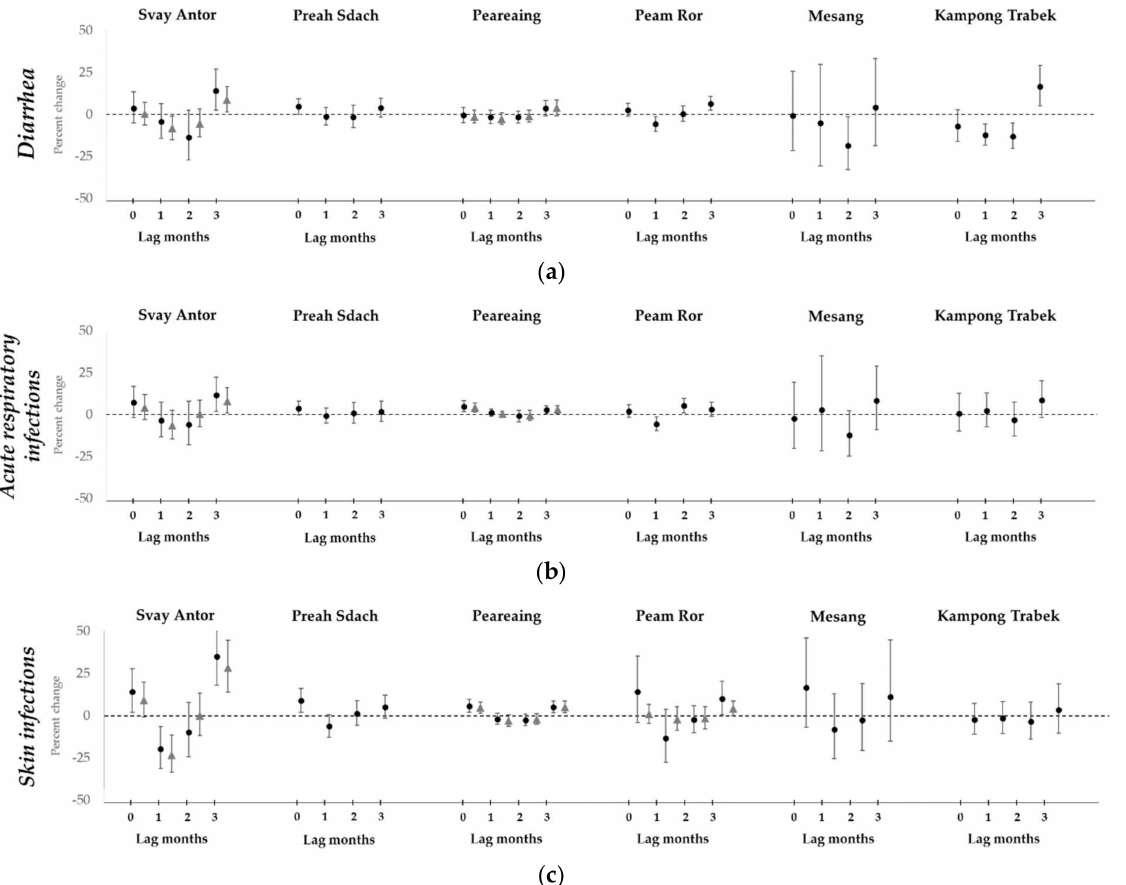
Figure 5. Percent change with 95% confidence interval in incidence rates of ( a ) diarrhea; ( b ) acute respiratory infections; and ( c ) skin infections, for every ten square kilometers of flood water in selected districts. Points marked with a circle are estimates using non-imputed data. Points marked with a triangle are estimates using imputed